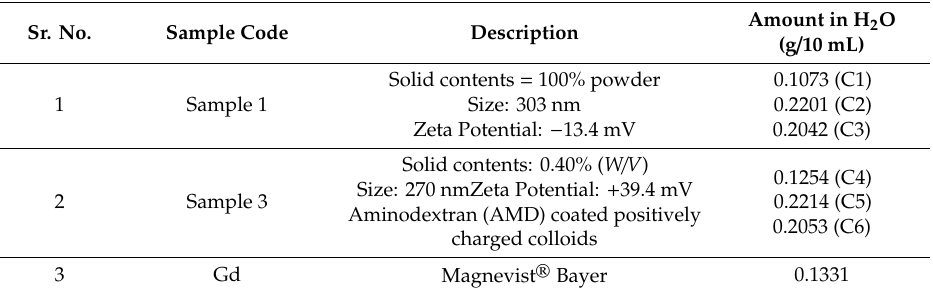
Table 2. Details and concentrations of samples prepared for the transmission electron microscopy (TEM) scans.